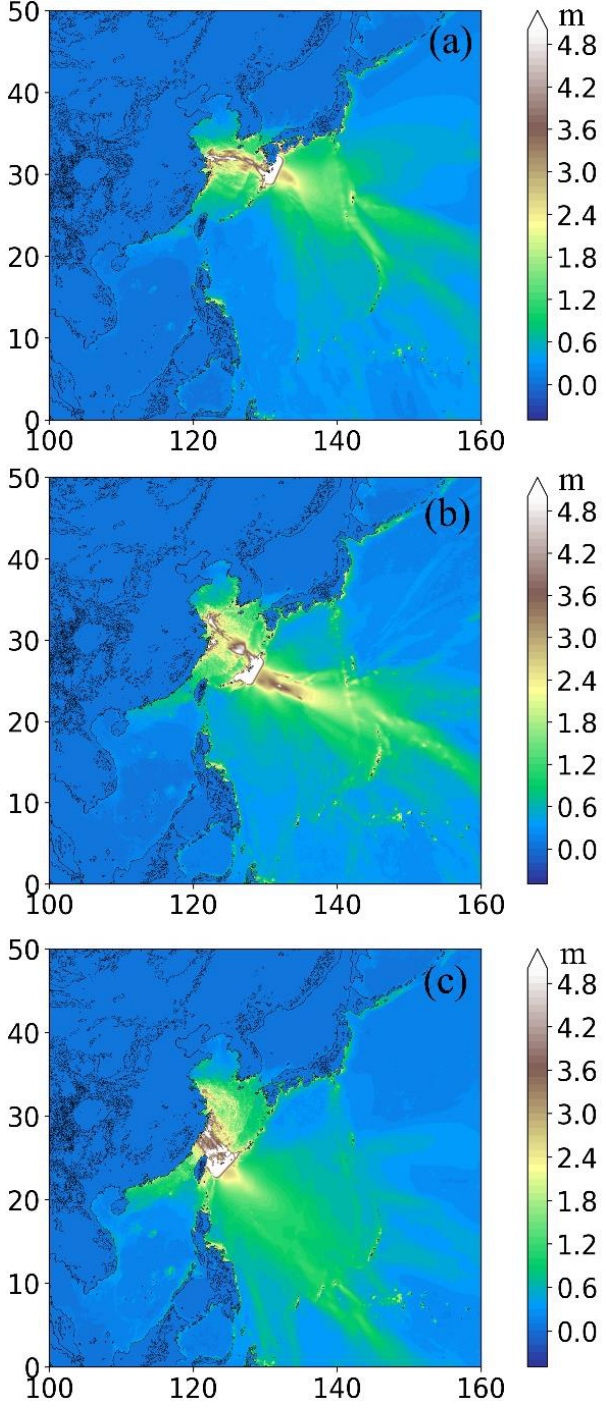
Figure 3. The maximum tsunami amplitude of layer 1: ( a ) tsunami source in the northern part of the Ryukyu Trench, ( b ) tsunami source in the middle of the Ryukyu Trench, ( c ) tsunami source in the southern part of the Ryukyu Trench.